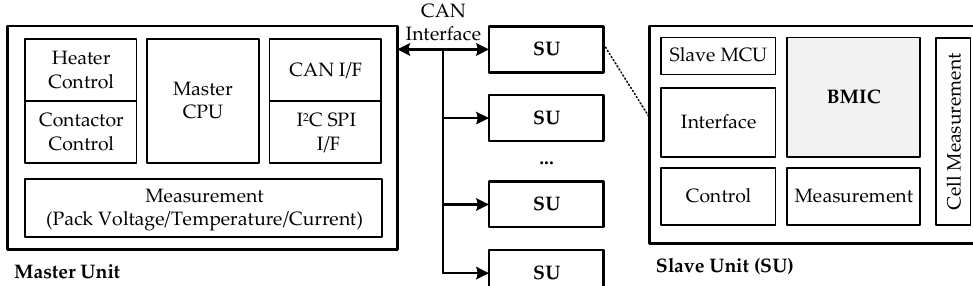
Figure 1. The structure of the proposed BMS.